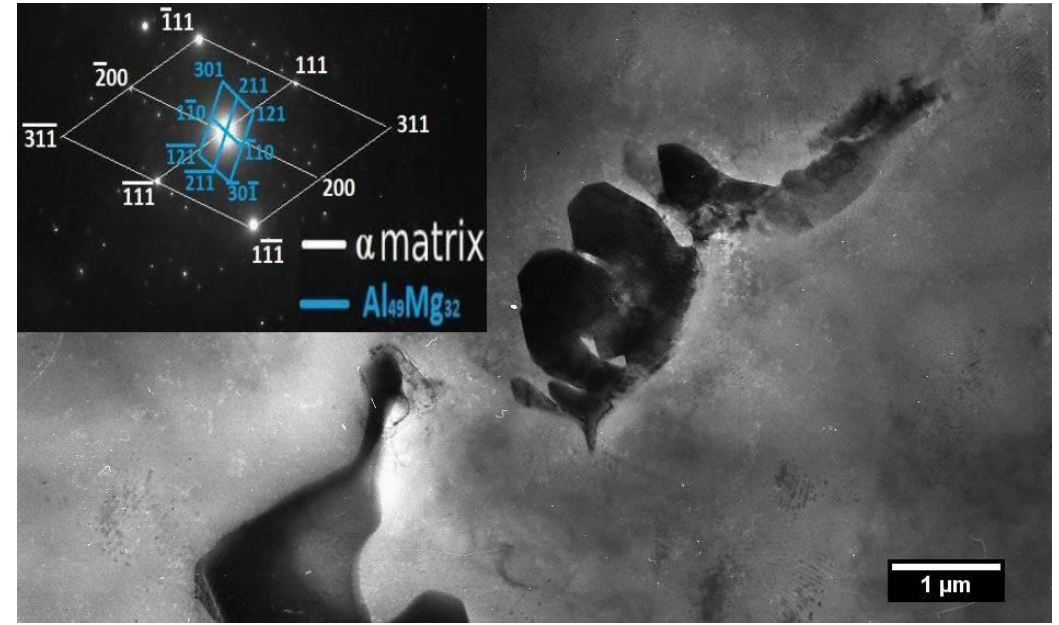
Figure 12. TEM image of the WM microstructure. The intermetallic phase Al 49 Mg 32 was identified by electron diffraction inside the inter-dendritic area. Metals 2020 , 10 , x FOR PEER REVIEW 15 of 24